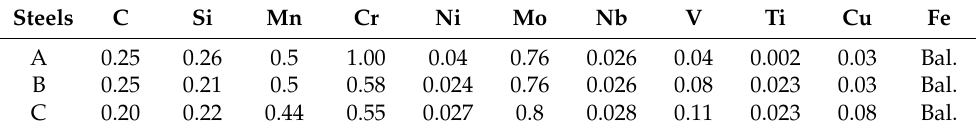
Table 1. Chemical compositions of three modified 110 ksi casing steel (wt%).